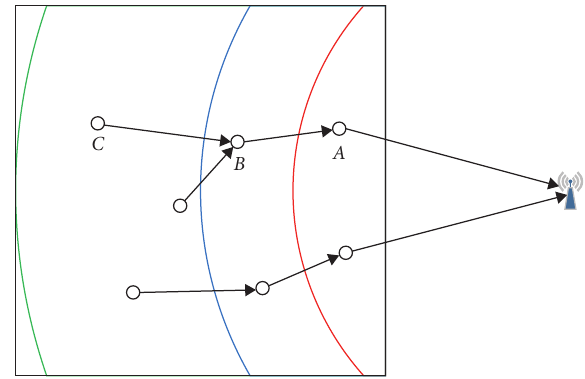
Figure 2: Partitioning method in the routing